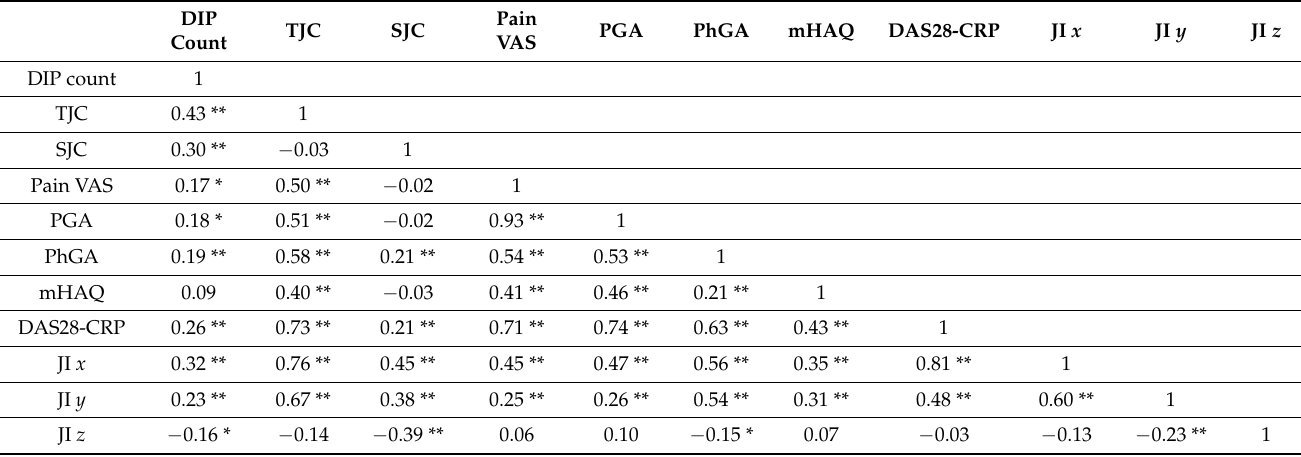
Table 2. Correlation coefficients among the numbers of affected distal interphalangeal (DIP) joints and clinical variables in patients with rheumatoid arthritis (RA) exhibiting DIP joint involvement.